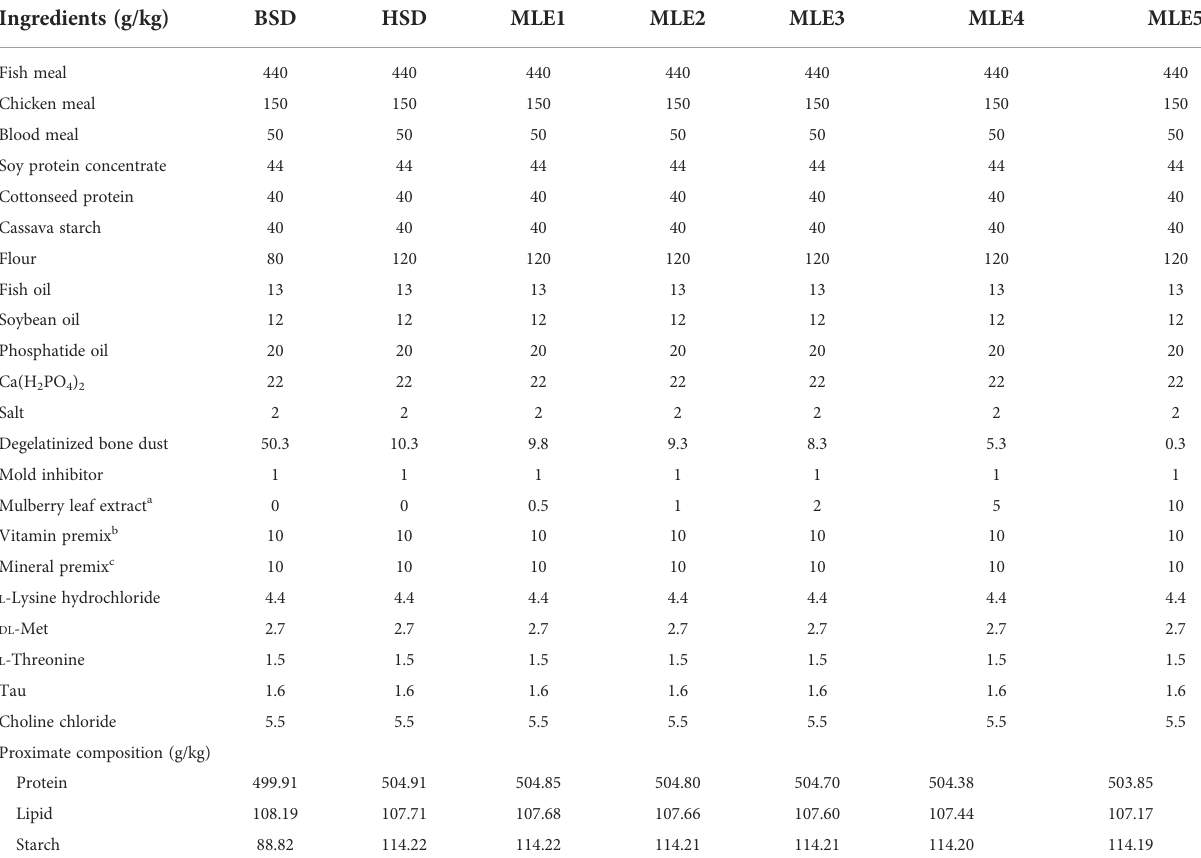
TABLE 1 Formulation and chemical composition of experimental diets (g/kg, dry